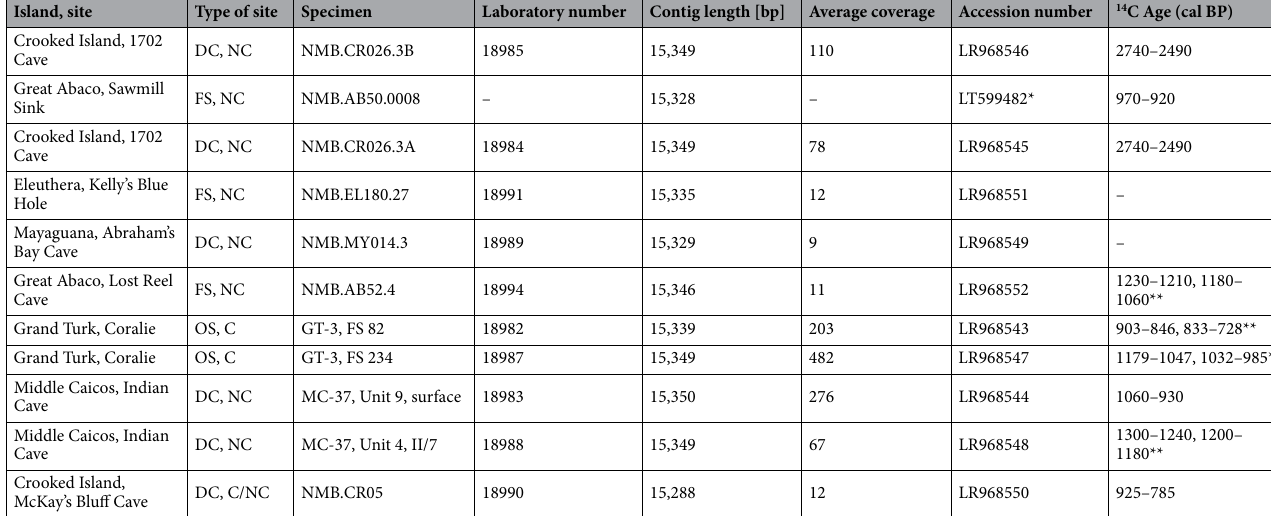
Table 1. The specimens of Bahamian tortoise ( Chelonoidis alburyorum ) with aDNA sequences reported in this paper. The vertical sequence here matches the vertical sequence in the time tree. Type of site categories: DC dry cave, FS flooded sinkhole (blue hole), OS open site, C cultural, NC non-cultural. 14 C Age (cal BP) radiocarbon age in calibrated years Before Present (2σ) from Steadman et al. 20 . Specimens are in the collection of the National Museum of The Bahamas (NMB), except for Grand Turk and Middle Caicos, which are in the Turks and Caicos National Museum and for which we provide field provenience. See Table S1 for further details. *Sequenced in a previous study 19 . **Two age ranges due to natural atmospheric variation through time in abundance of 14 C because of sunspot activity; see Steadman et al. 20